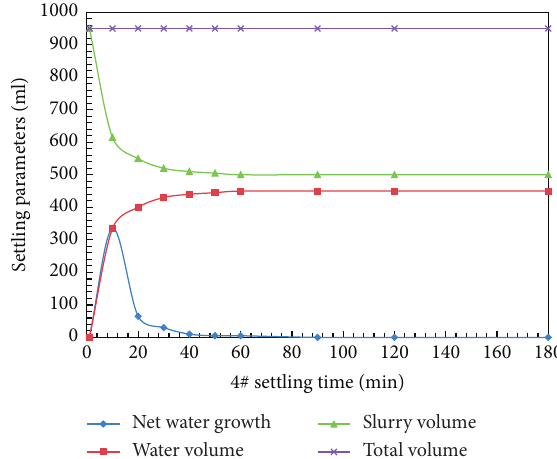
Figure 9: Flocculating sedimentation test parameters of tailings